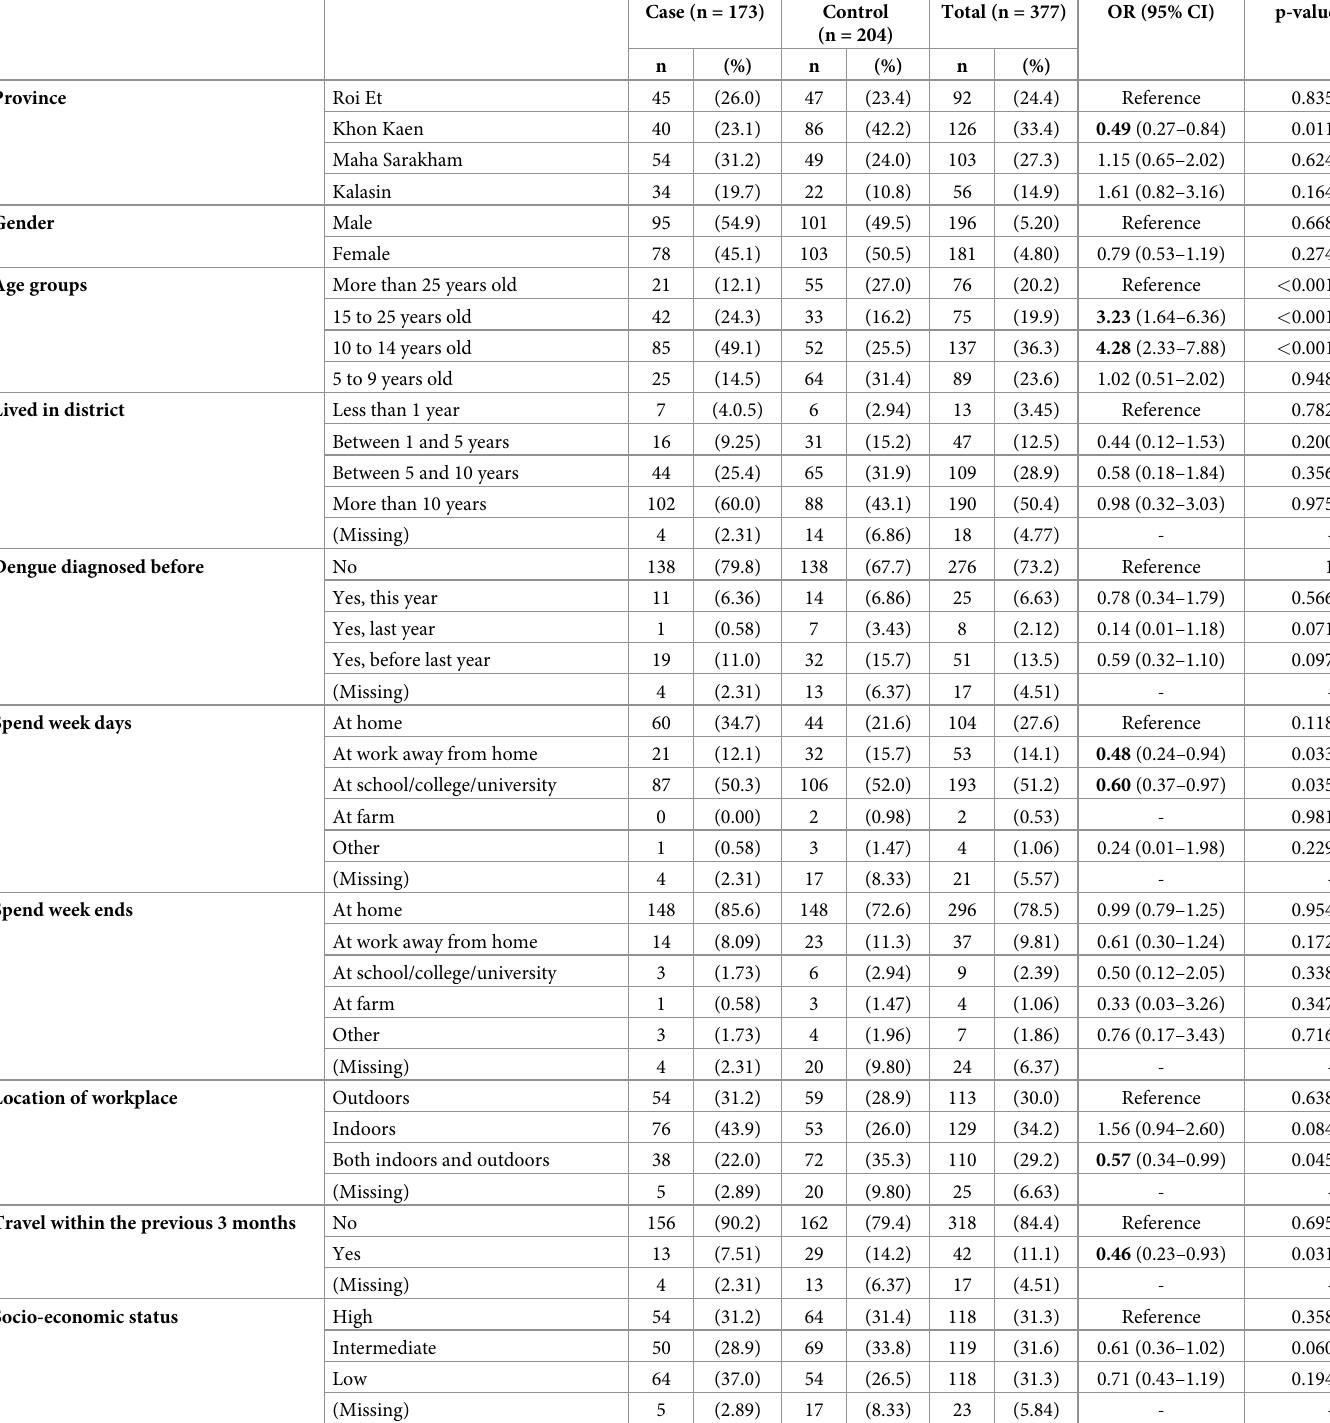
Table 1. Individual and household characteristics and their associations with dengue fever cases in northeastern Thailand, June 2016 and July 2019. Odds ratios (OR), obtained by logistic univariable regression, in bold text are significant (p < 0.05). Missing data by individual not included in the